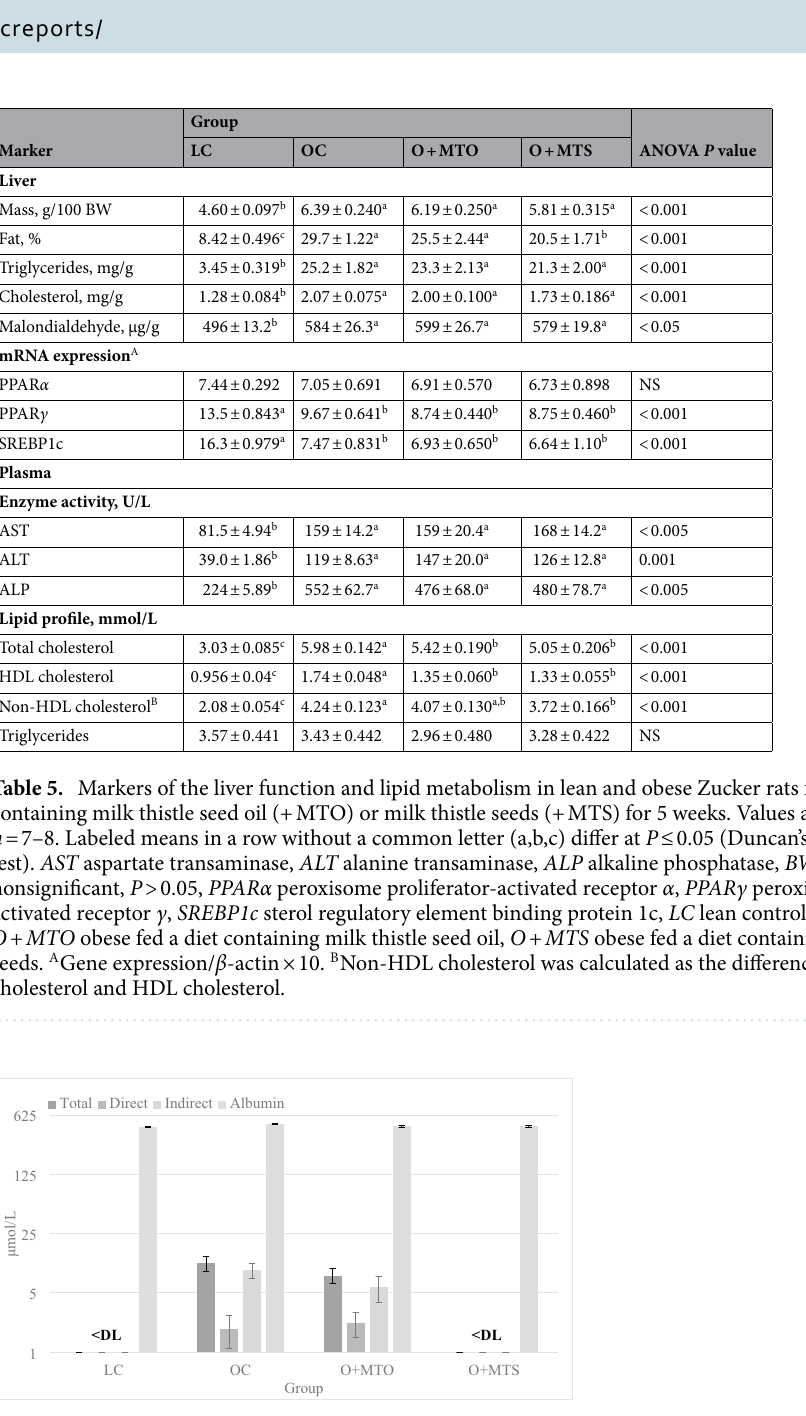
Figure 1. Plasma bilirubin and albumin concentration in lean and obese Zucker rats fed a diet containing milk thistle seed oil (+ MTO) or milk thistle seeds (+ MTS) for 5 weeks. Values are means ± SEMs, n = 7–8. DL detection limit for total bilirubin = 2.9 µmol/L and for direct bilirubin = 1.6 µmol/L, LC lean control, OC obese control, O + MTO obese fed a diet containing milk thistle seed oil, O + MTS obese fed a diet containing milk thistle seeds. Indirect bilirubin was calculated as the difference between total and direct